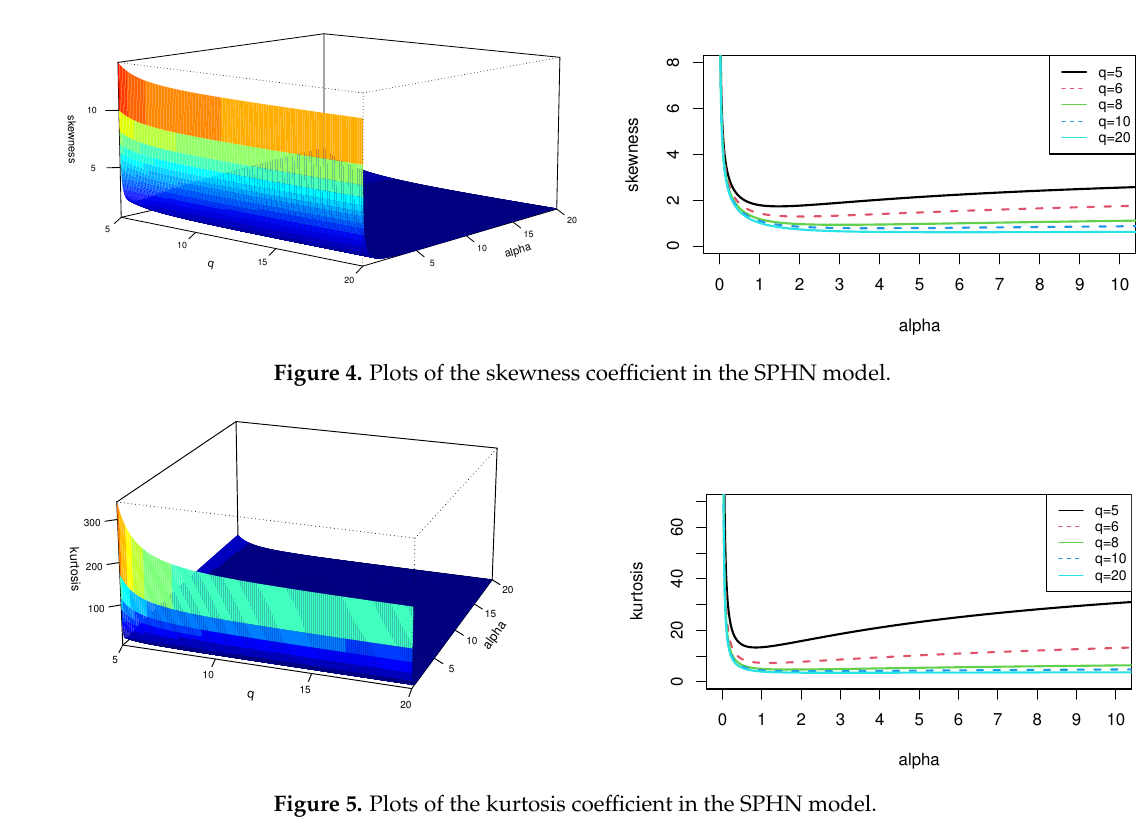
Figure 5. Plots of the kurtosis coefficient in the SPHN model.